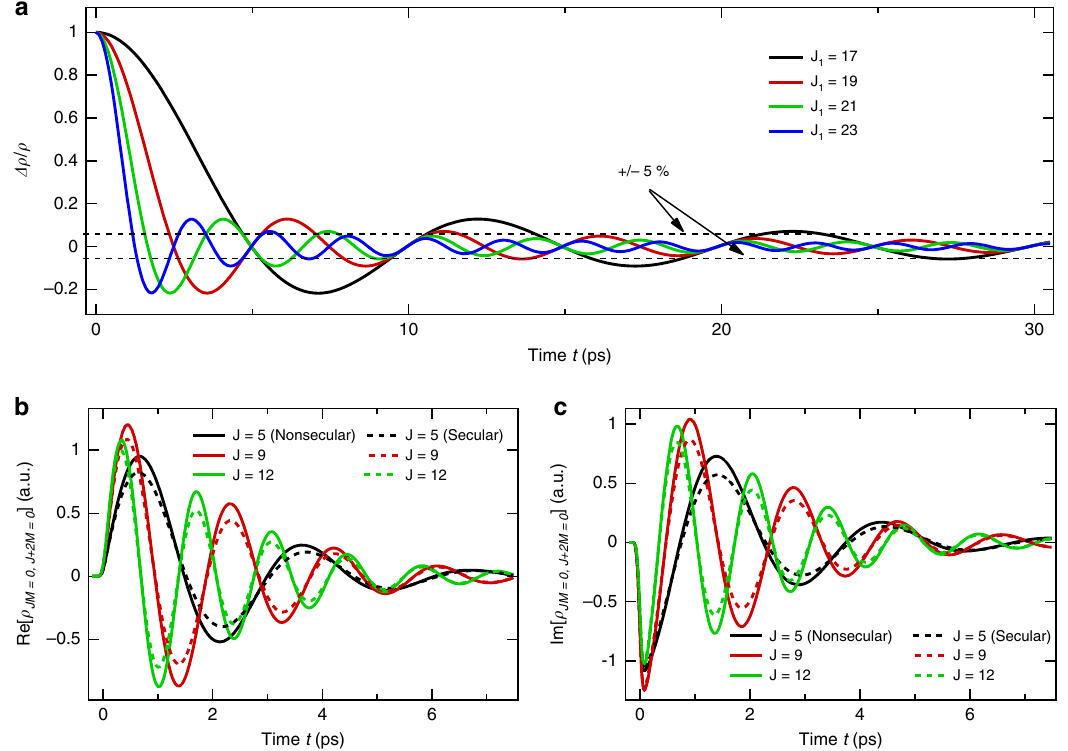
ð t Þ coherence for J = 15 induced by collisional transfers from the Fig. 4 Secular and nonsecular effects. a Relative modi fi cation of the ρ J 0 0 M 0 ; J 0 þ 2 M 0 coherences ρ the short time evolution of the system, exchanges between coherences are ef fi cient, which slow down the decay of the alignment factor with respect to what would be obtained using the secular approximation that neglects these collisional transfers and only takes the losses into account. b , c Computed real ð t Þ coherences for N and imaginary parts of the ρ JM ¼ 2 O in He at 33 amagat, obtained using the nonsecular (full lines) and secular (dashed lines) 0 ; J þ 2 M ¼ 0